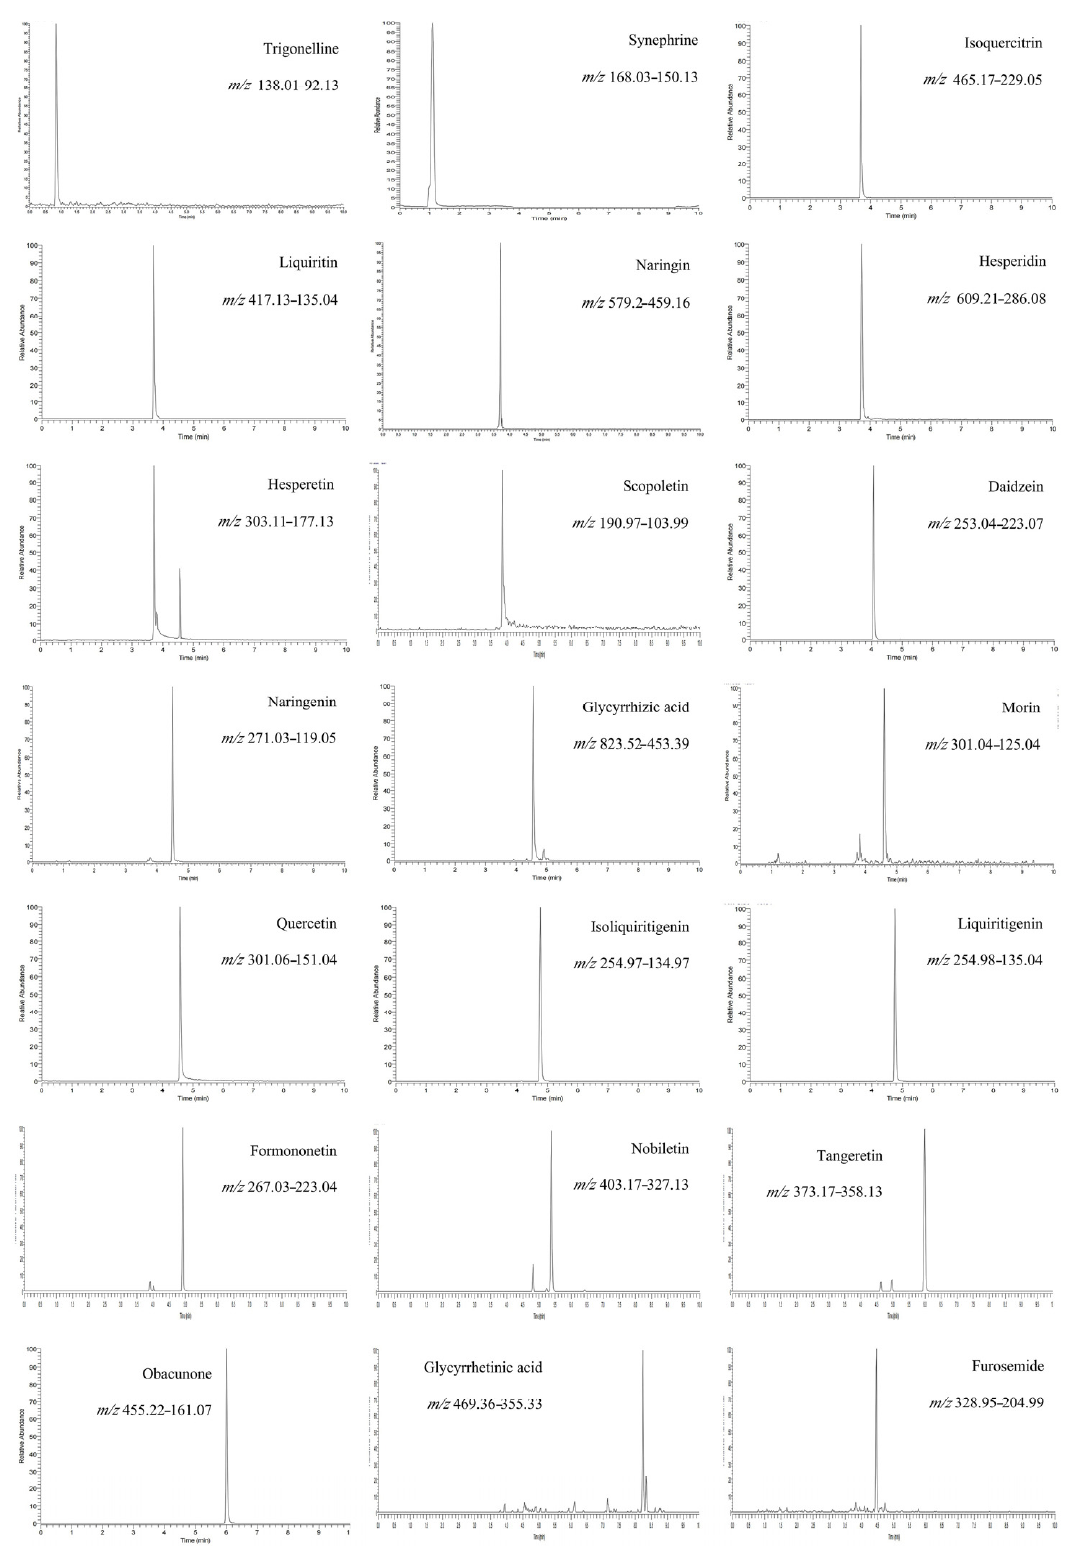
Figure 2. Chromatographic behavior of 20 compounds and IS. Table 1. List of quantified 20 compounds of WDD and IS parameters.